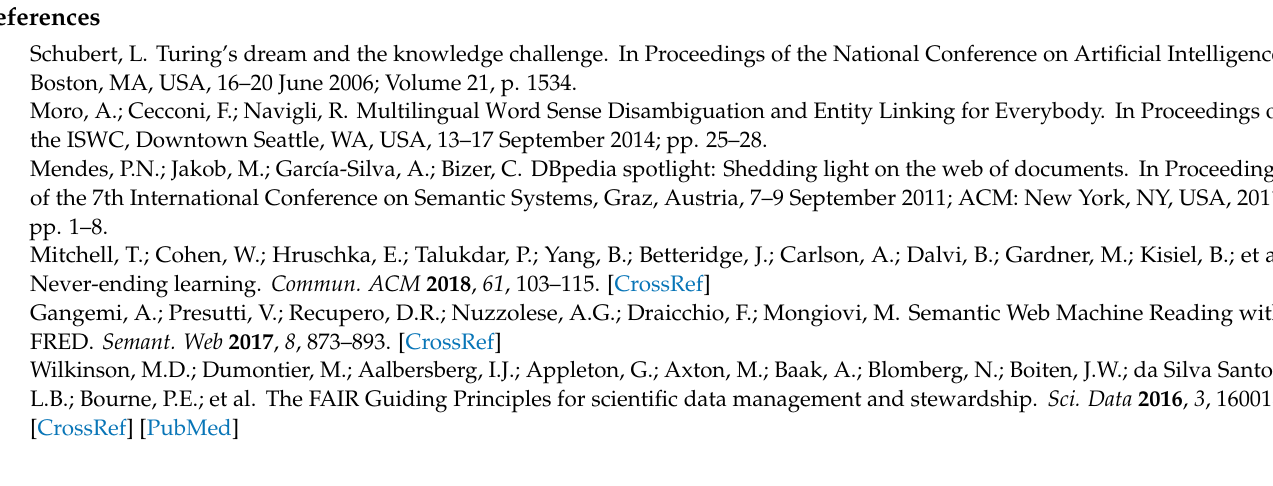
Figure A9. Structured KG representation of a Medical domain publication Abstract [73] as process, method, material, and data typed